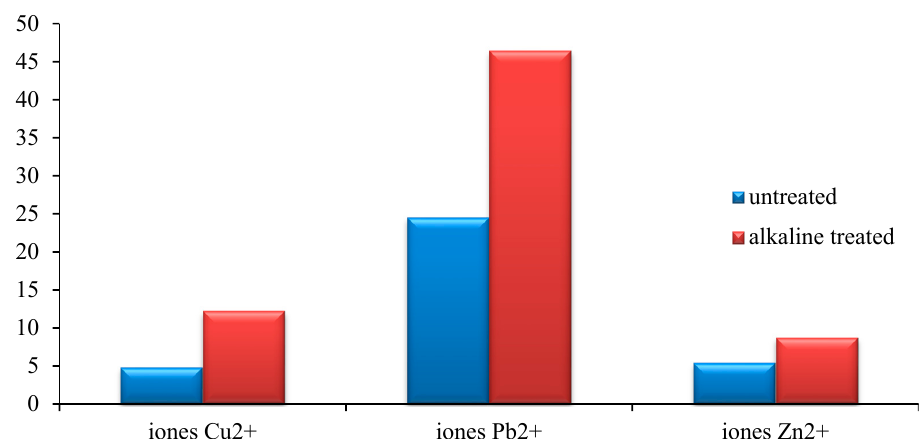
Figure 8. Influence of alkaline treatment of apricot kernel shells on the sorption capacity with respect to ions Cu 2+ , Pb 2+ and Zn 2+.